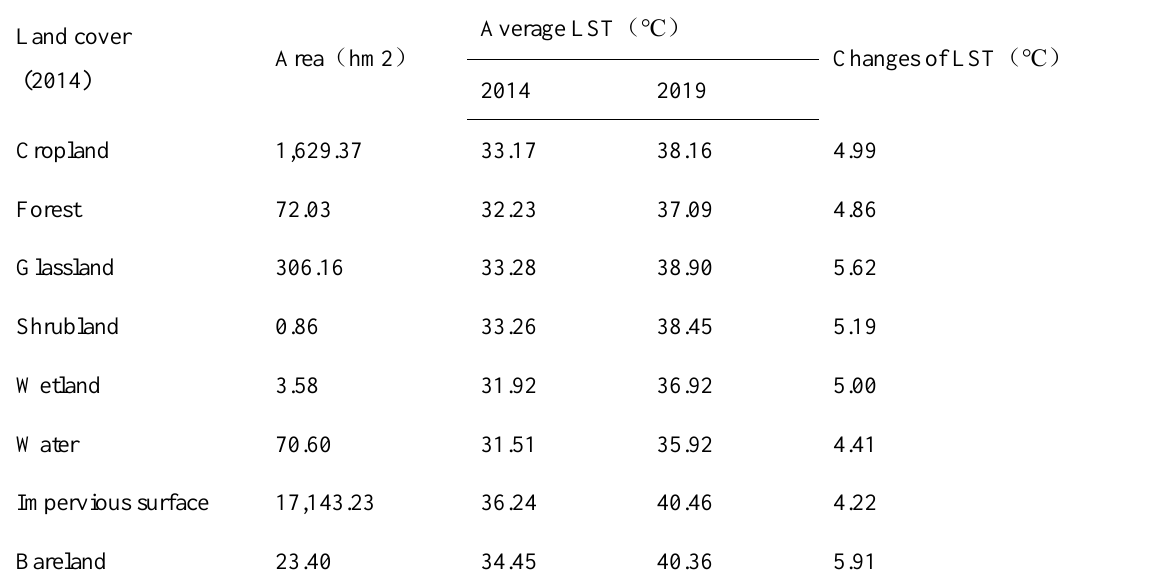
Table 4. Average LST and its variation in different land cover